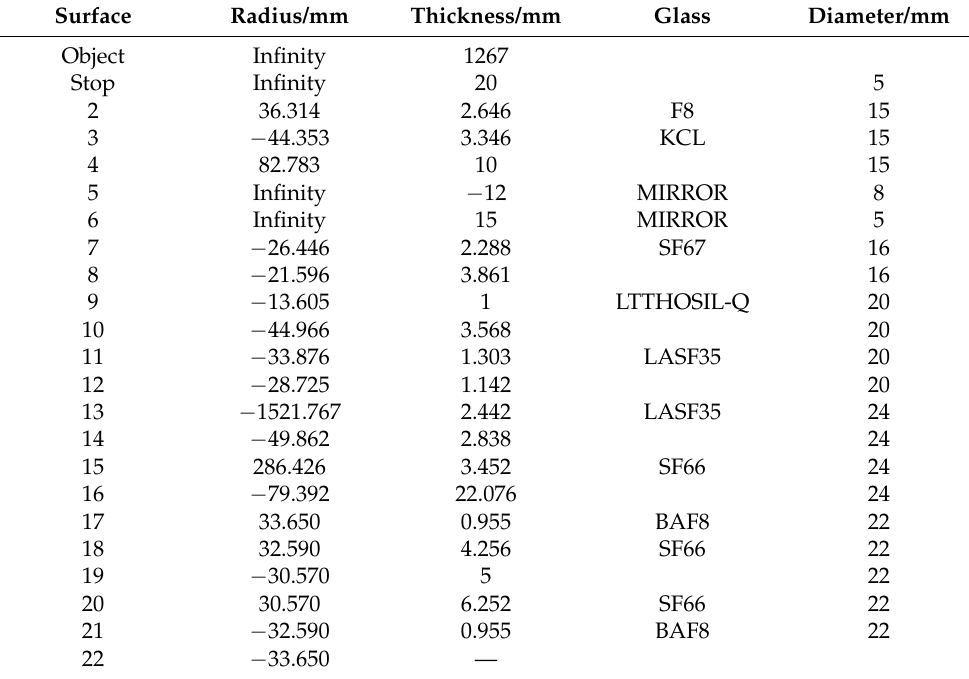
Figure 8. Three-dimensional structure the large-angle MEMS scanning optical system. Table 2. Design parameters of MEMS scanning optical system.